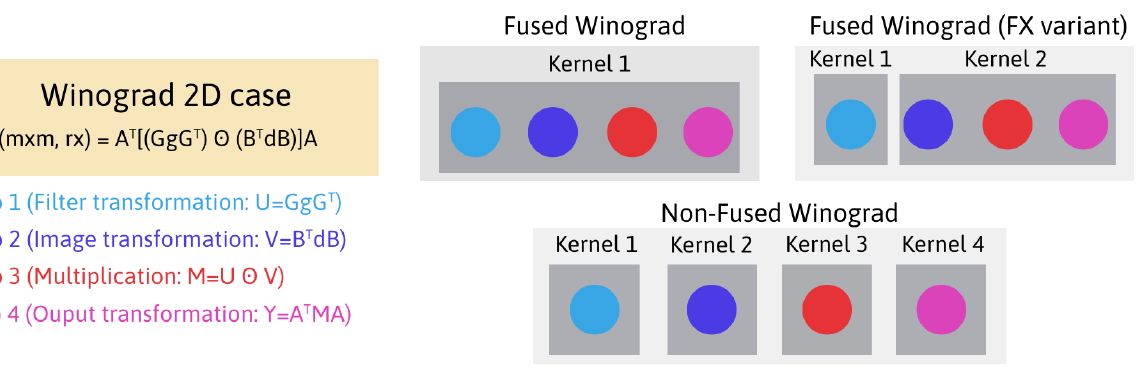
Figure 3. Implementation alternatives of Winograd’s